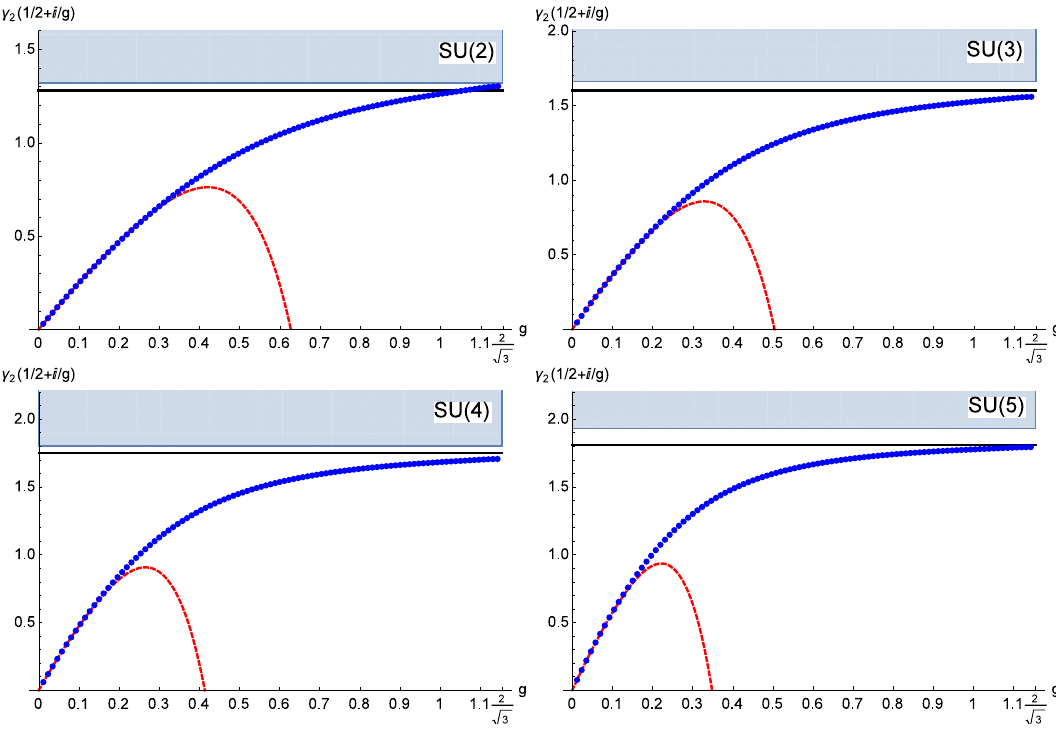
Figure 6 . Similar plots for the spin-2 operator as (cid:12)gure 3. The interpolating function F (30 ; 1 = 4) for (cid:28) = i=g is plotted as the function of g .